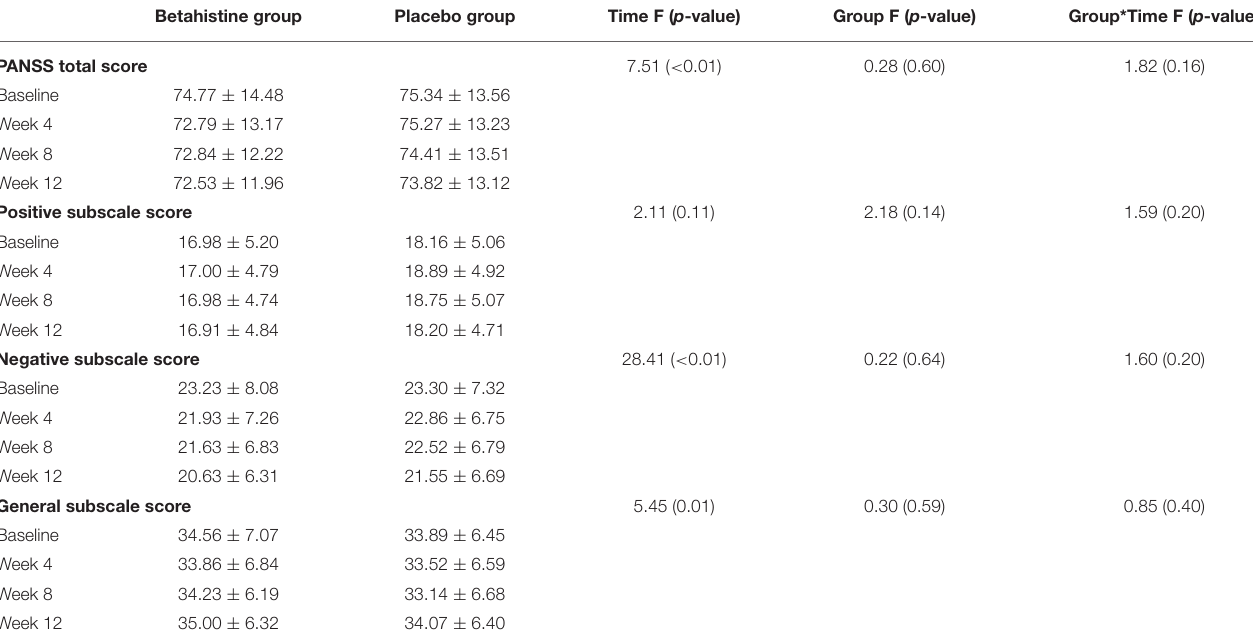
TABLE 3 | PANSS total and subscale scores at baseline, week 4, week 8, and week 12 in the betahistine and placebo groups. Betahistine